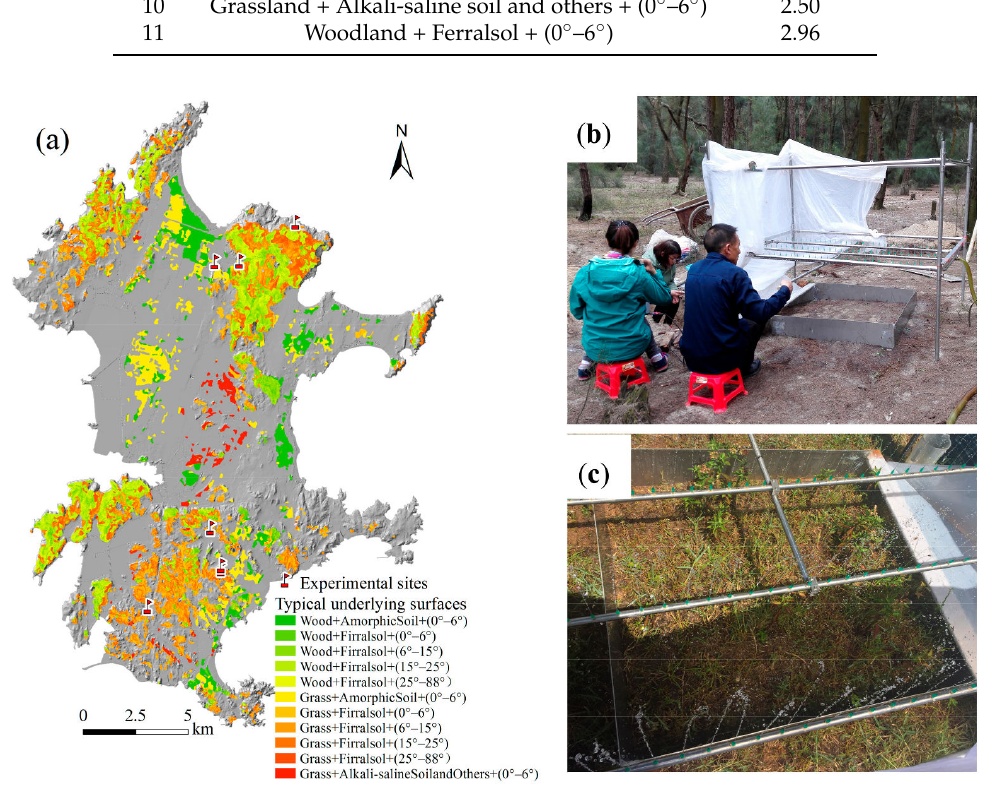
Figure 2. ( a ) Spatial distribution of underlying surface types and selected sites for the field rainfall-runoff experiments; ( b ) Conducting field experiments; and ( c ) A field site for experiments (1 m × 1